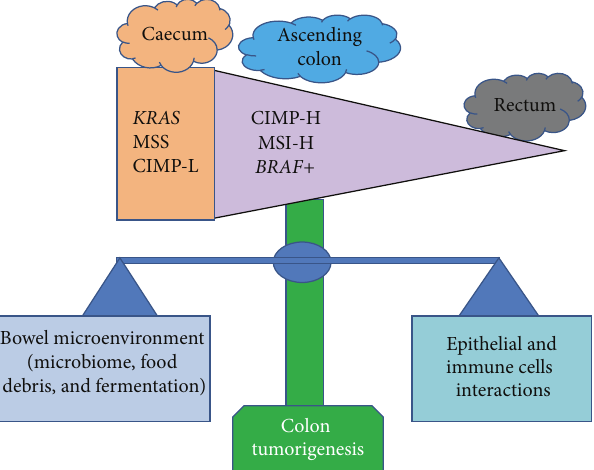
Figure 1: Bowel microenvironment influences CRC molecular features and progression. The CIMP-high, MSI-high, and BRAF mutations frequencies gradually increase from the rectum to ascending colon. Caecal cancers seem to represent a distinct subtype characterized by a higher frequency of KRAS mutations, a MSS, and CIMP-L phenotype. In the bowel microenvironment, changes in the balance between (1) microbiome, food debris, and bacterial fermentation products and (2) interactions with host cells (epithelial and immune cells) might predispose colon epithelial cells to certain molecular insults and differentially influence tumour development according to molecular features in preneoplastic cells. CpG island methylatorphenotype:CIMP;microsatelliteinstability:MSI;CIMP- low: